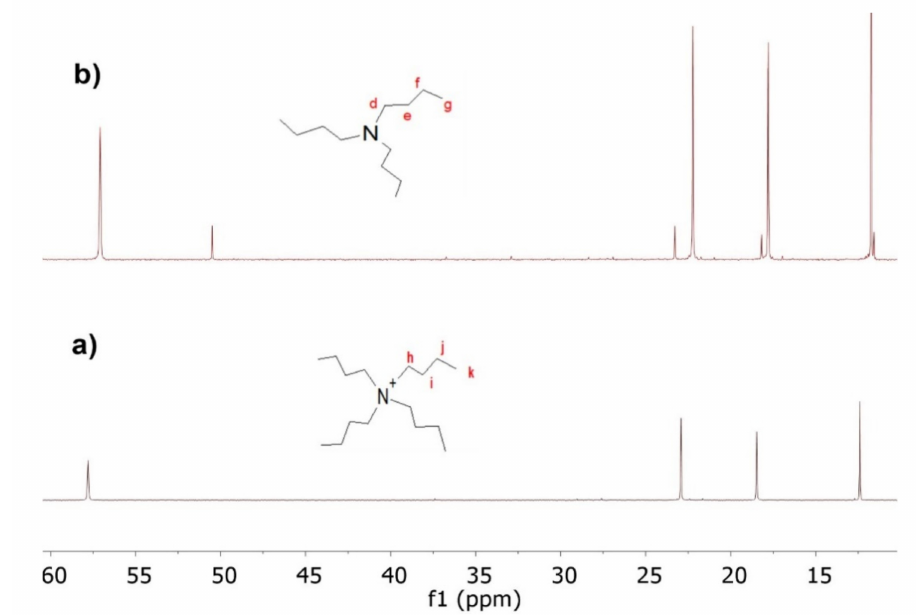
Figure 7. 13 C-NMR spectrum of ( a ) TBAB, and ( b ) trimethylamine as a byproduct or the TBAB+CO 2 reaction in absence of ELO at 120 ◦ C, 90 psi, and 48